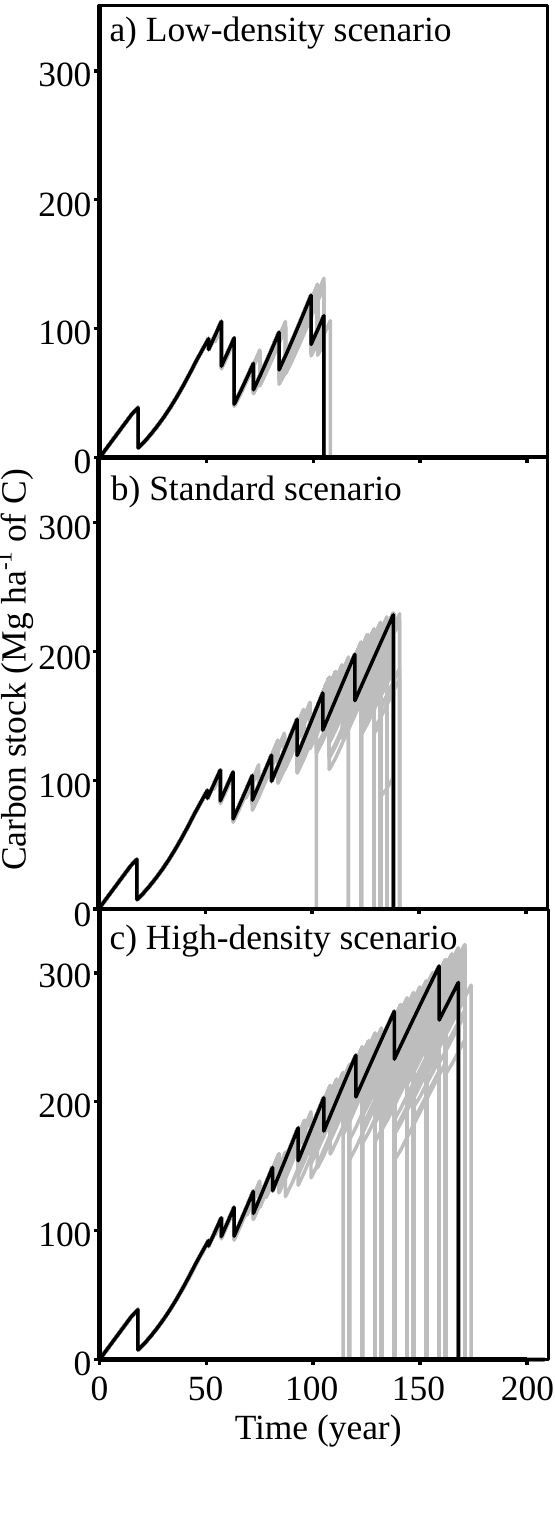
Figure 3. Evolution of the carbon stocks in the forest carbon pool for three different management scenarios (black: without wind damage; gray: realizations with stochastic wind